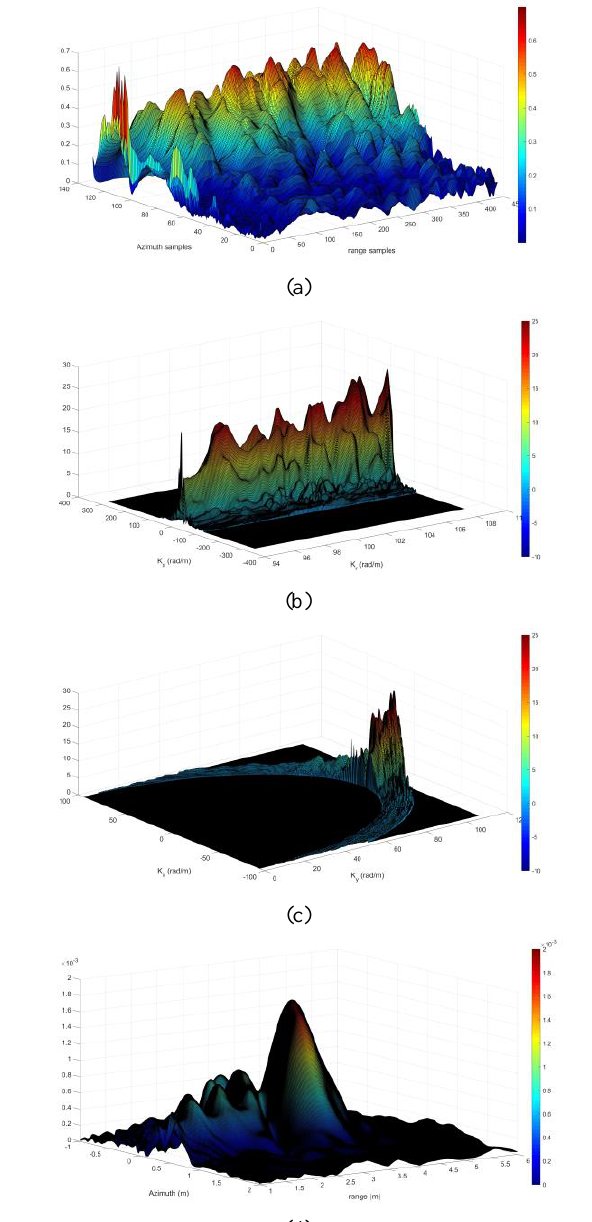
Figure 10. RMA steps in SAR image generation. (a) raw 2-D signals as algorithm’s input (b) signals after along-track Fourier transform and initial phase compensations (c) signals after Stolt interpolation (d) signals after two-dimensional inverse Fourier transform (focused signal) Focusing capability of the generated SAR image is evaluated with the peak sidelobe ratio (PSLR) of the focused target in the Figure 9. SAR imaging result. (a) raw 2-D signals (b) focused range and azimuth direction of the imaging scene. PSLR is final SAR image